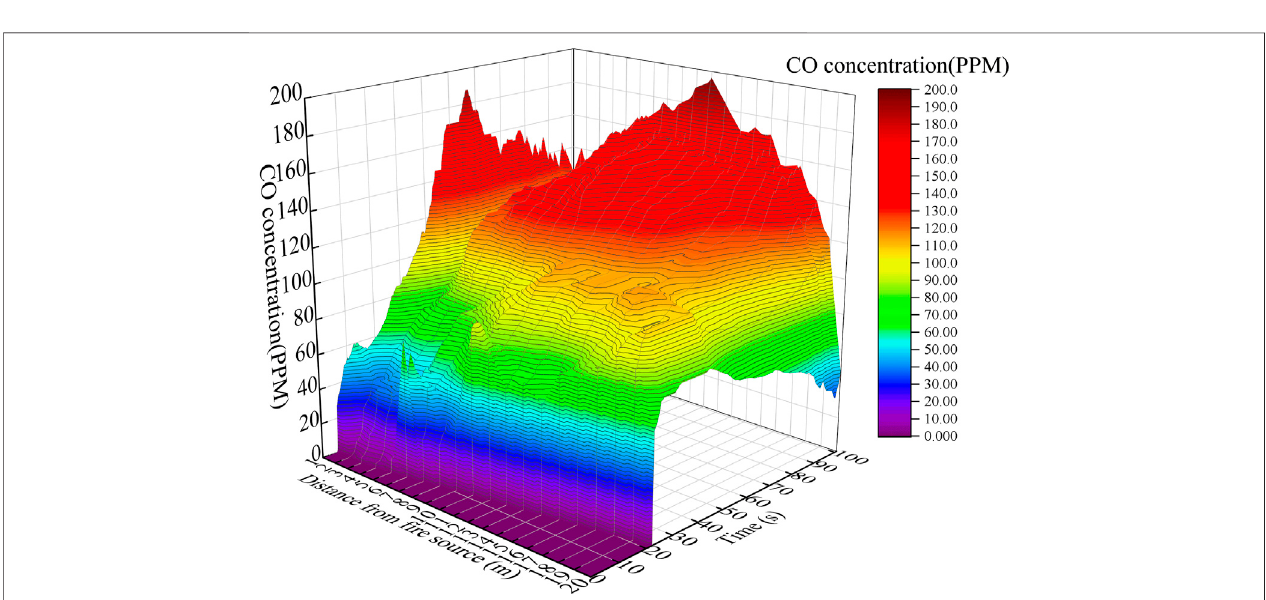
FIGURE 7 | Variation curve of CO concentration ( fi re source power 600